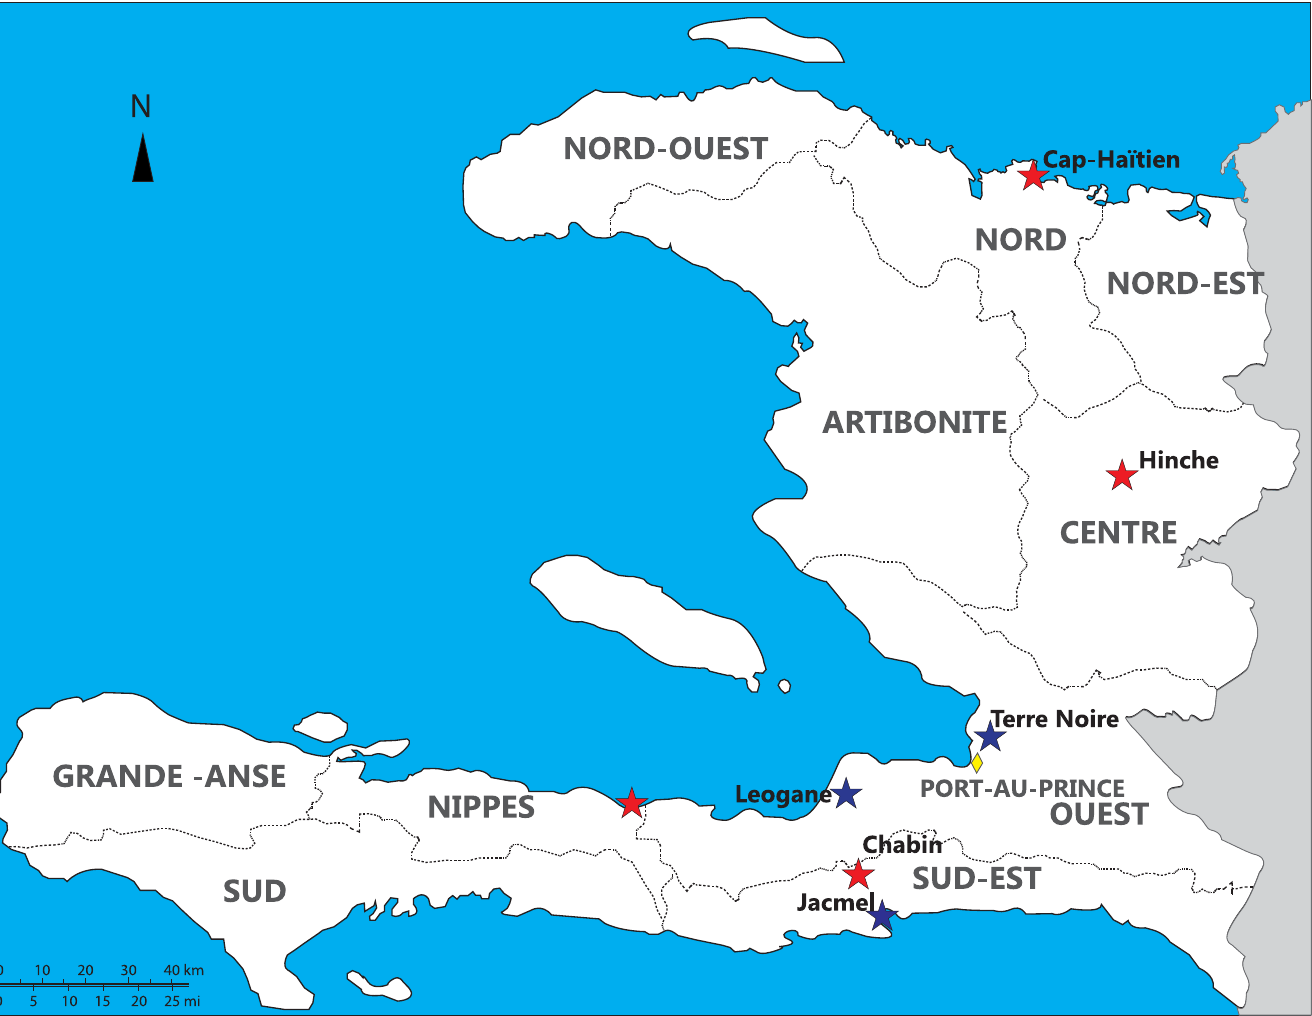
Fig 1. Map of study sites in Haiti. Study sites are indicated by the colored stars. Blue stars indicate the study sites where the majority of samples were collected.